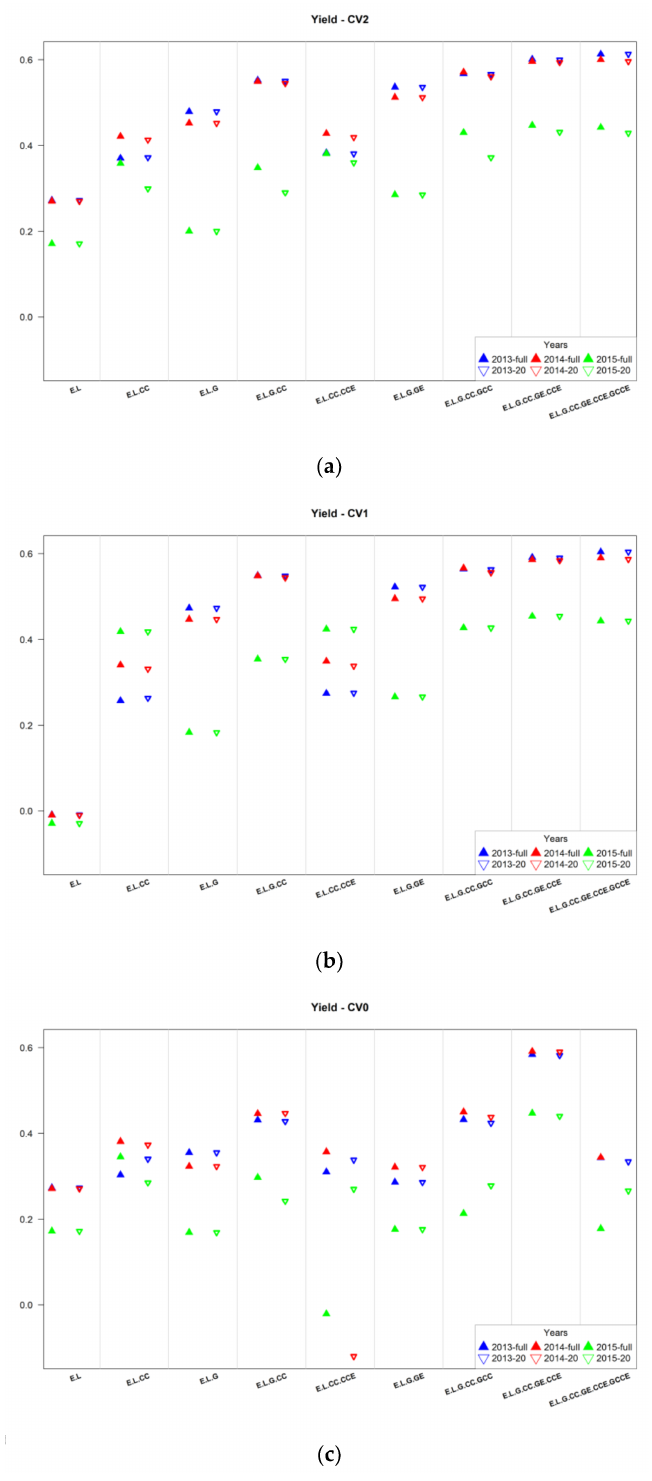
Figure 5. Average prediction accuracy obtained for the nine models for yield using the CV2 ( a ); CV1 ( b ); and CV0 ( c ) cross-validation schemes for the complete (days 14–71) and reduced (days 14–33) canopy sets. The three different colors represent the years for which the prediction was carried